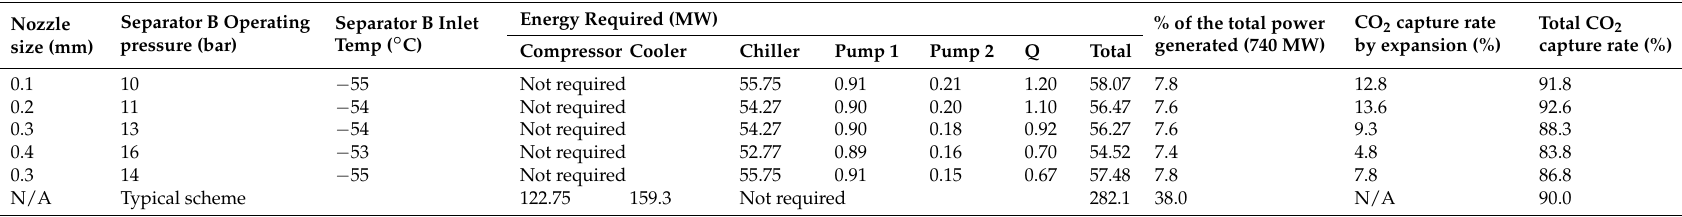
Table 4. Simulated results of the energy required for a typical 740 MW IGCC GE power plant with and without the energy-saving scheme and the experimental results of the CO 2 capture rate obtained from the